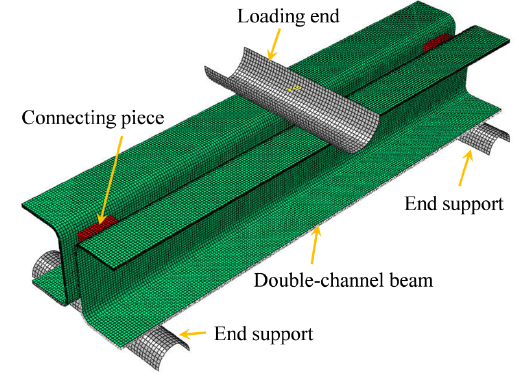
Figure 8: Finite element model of double-channel CARALL beams subjected to three-point bending